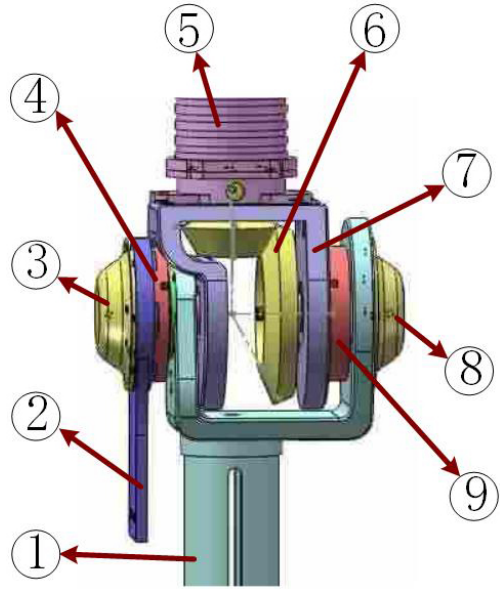
Figure 8. Experiment protocol of the performance